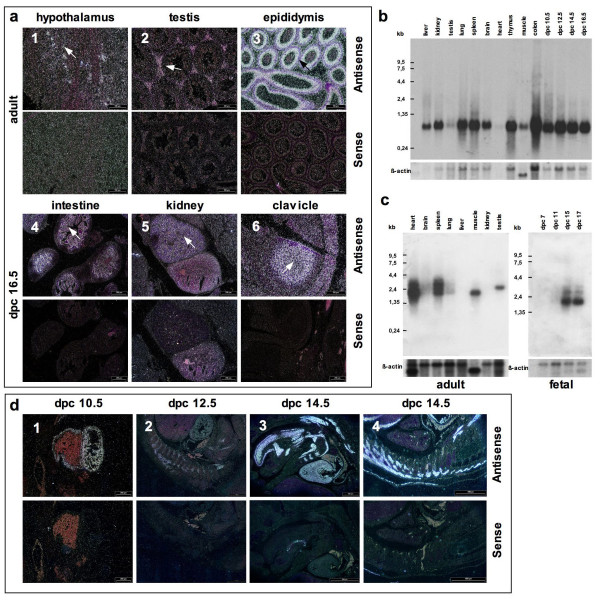
Experimental results for Rpl10 (a-b) and Stk23 (c-d). a. In situ hybridisation of Rpl10 on adult and embryonic tissues. Upper panels: antisense probe, lower panels: sense probe. 1 hypothalamus with signal in the nucleus of a sagittal brain section, 2 adult testis with signal in leydig cells, 3 epididymis, 4 dpc 16.5 intestine, 5 dpc 16.5 kidney, 6 dpc 16.5 skeletal system/clavicle. b. Northern hybridisation with a Rpl10-specific probe on a self-made MTN blot, 15 μg of murine total RNA per lane. c. Northern hybridisation with a Stk23-specific probe on Clontech adult and embryonic MTN blots. d. RNA in situ hybridisation of Stk23 in different embryonic stages. 1 dpc 10.5 heart, 2 dpc 12.5 intercostal muscles, 3 dpc 14.5 tongue and heart, 4 dpc 14.5 intercostal muscles.